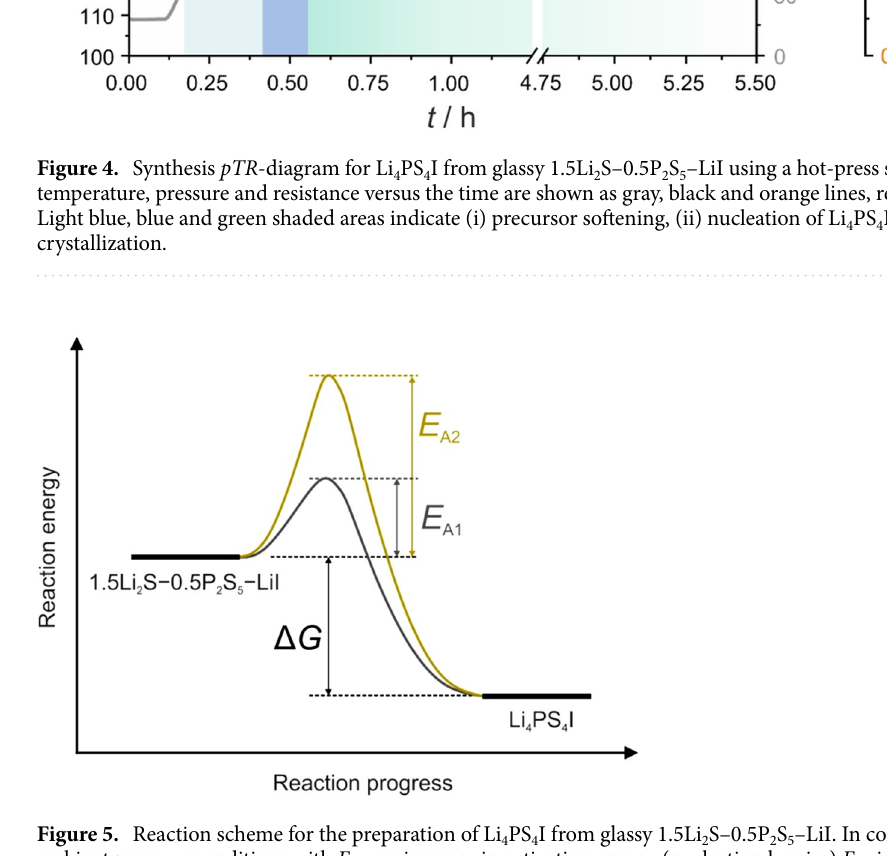
Figure 5. Reaction scheme for the preparation of Li 4 PS 4 I from glassy 1.5Li 2 S–0.5P 2 S 5 –LiI. In contrast to ambient pressure conditions with